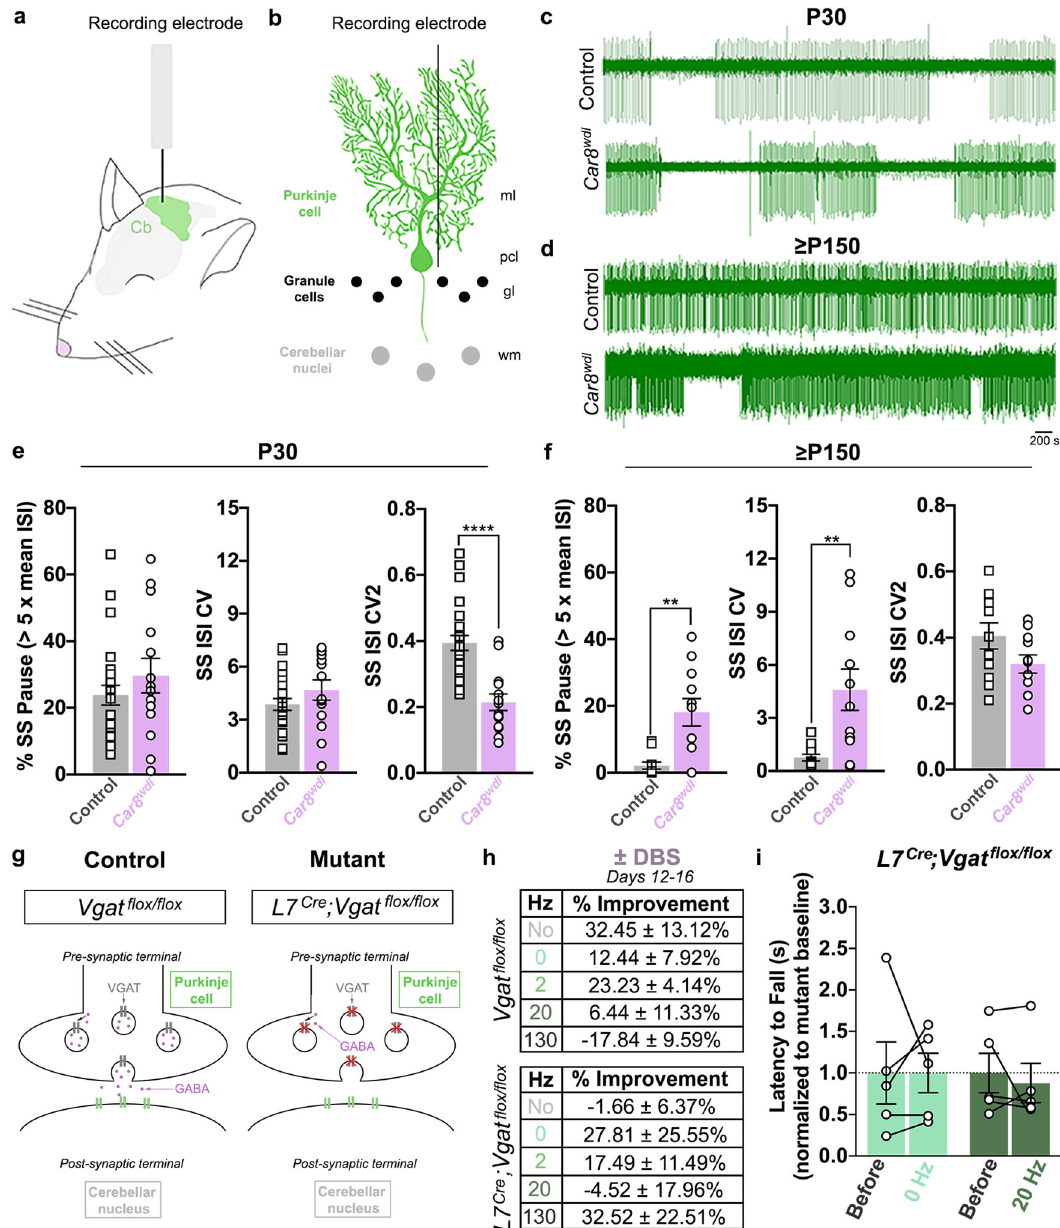
Fig. 6 Cerebellar DBS requires Purkinje cell neurotransmission to be effective. a Schematic of our in vivo electrophysiology, anesthetized setup. Cb (green) = cerebellum. b Schematic showing the extracellular recording of a Purkinje cell. ml = molecular layer; pcl = Purkinje cell layer; gl = granule layer; wm = white matter. c , d Example traces of Purkinje cell activity from P30 ( c ) and ≥ P150 ( d ) control and Car8 wdl mice. e P30 Car8 wdl Purkinje cells fi re as irregularly as age-matched control cells, on the whole ( p = 0.1969), but more regularly during local trains ( p < 0.0001). n = 39 cells (Control: n = 25; Car8 wdl : n = 14) from 7 biologically independent animals (Control: n = 4; Car8 wdl : n = 3) over 7 independent experiments. f Aged Car8 wdl Purkinje cells fi re more irregularly than do age-matched control cells, on the whole ( p = 0.0041), and equally as regular during local trains ( p = 0.0921). n = 22